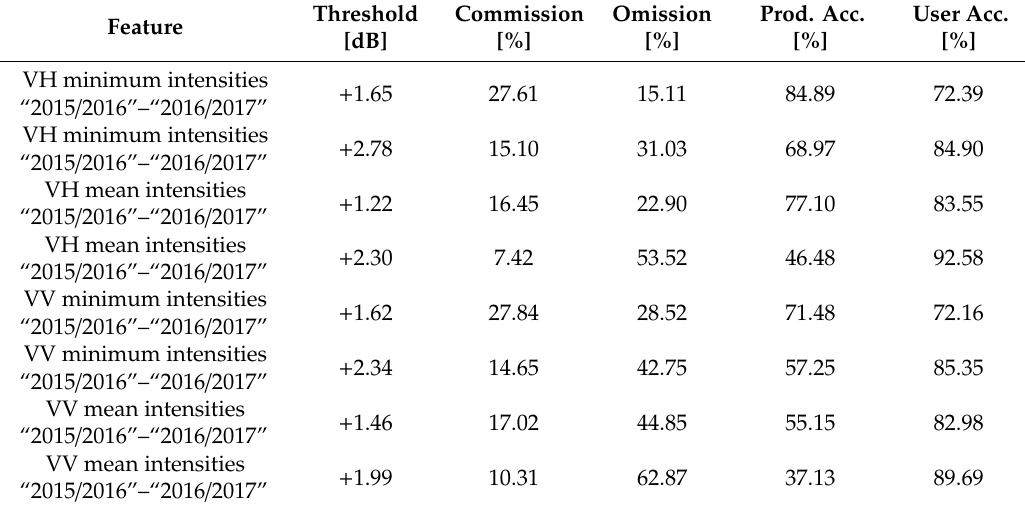
Table 3. Accuracy assessments of class “changed” based on the di ff erences between the VV / VH mean / minimum intensities between sets “2015 / 2016” and “2016 / 2017” (Period 1) (see Figure 9), the thresholds identified in Table 2 and reference data generated from the Google Earth Imagery (see Figures 1 and 8). Note: Prod. Acc. = Producer Accuracy, User Acc. = User Accuracy. Threshold Commission Omission Prod. Acc. User Feature [dB] [%] [%]